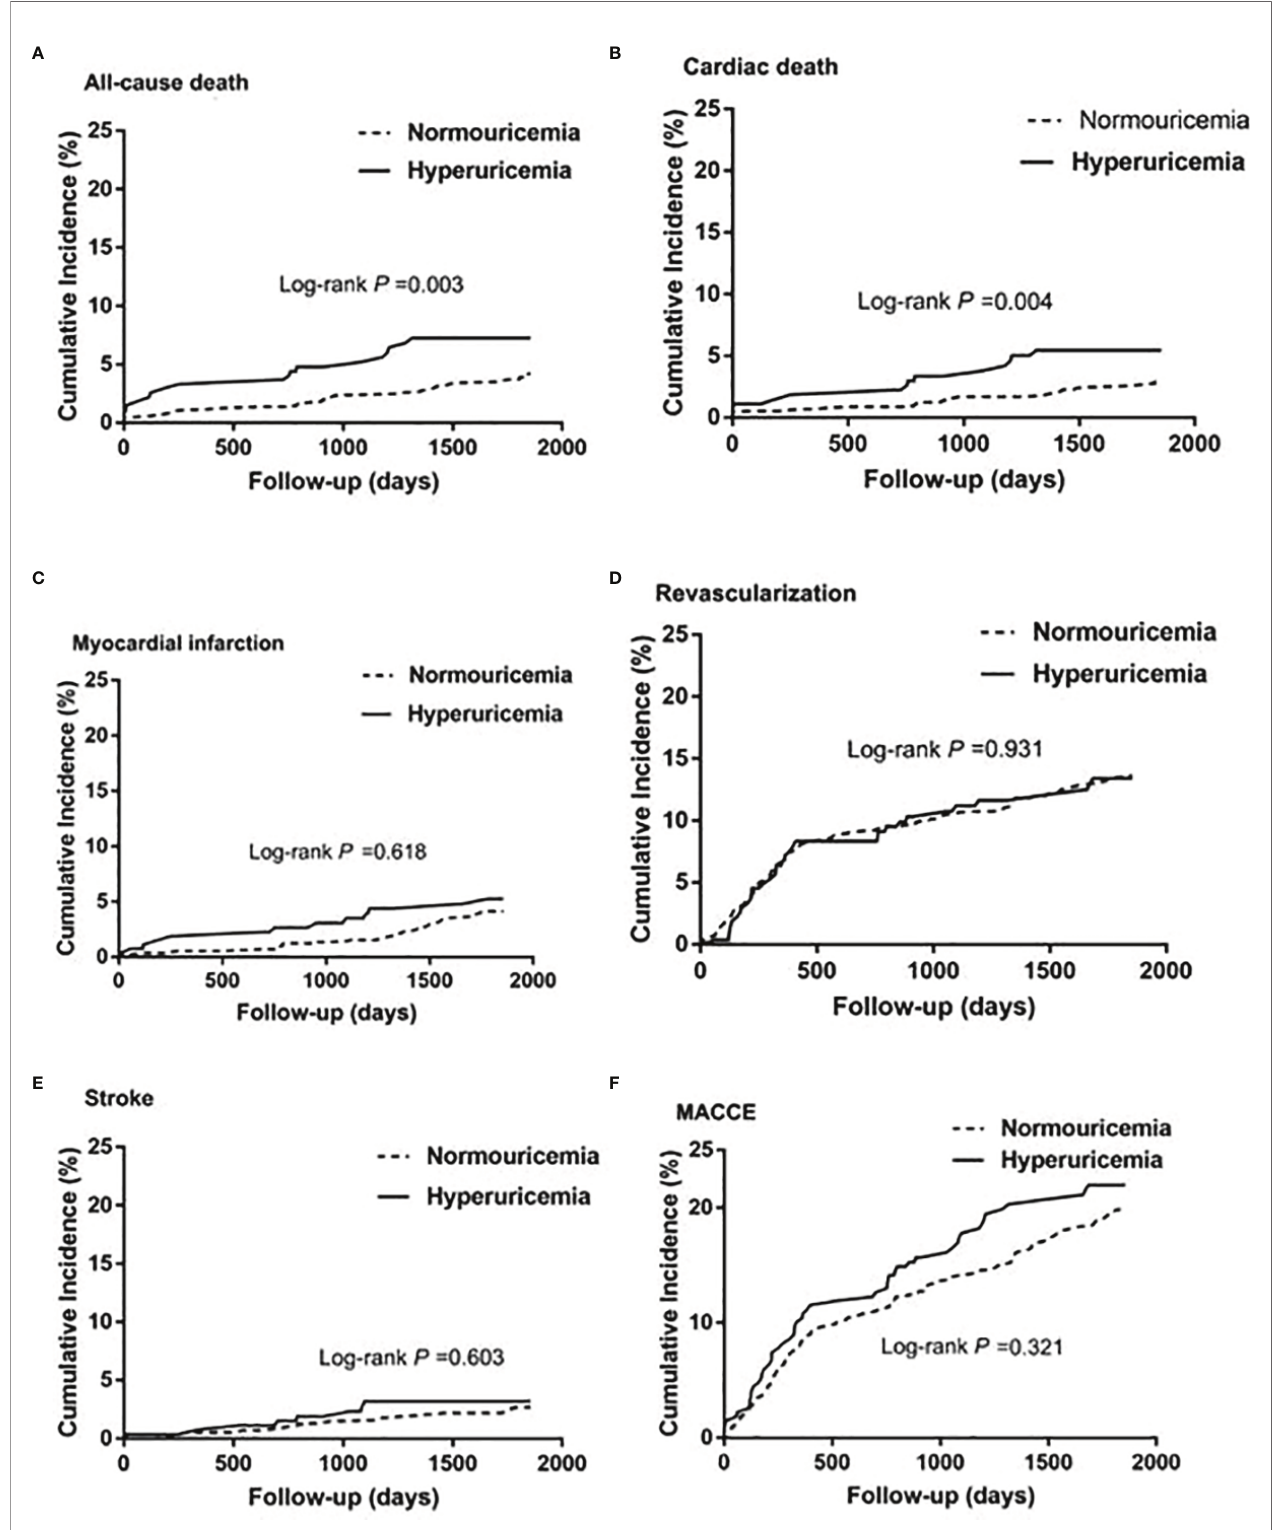
FIGURE 3 | Kaplan – Meier survival curves for 5-year primary and secondary outcomes in STEMI patients with PCI. (A) All-cause death, (B) cardiac death, (C) myocardial infarction, (D) unplanned revascularization, (E) stroke, and (F) MACCE. MACCE, major adverse cardiac and cerebrovascular